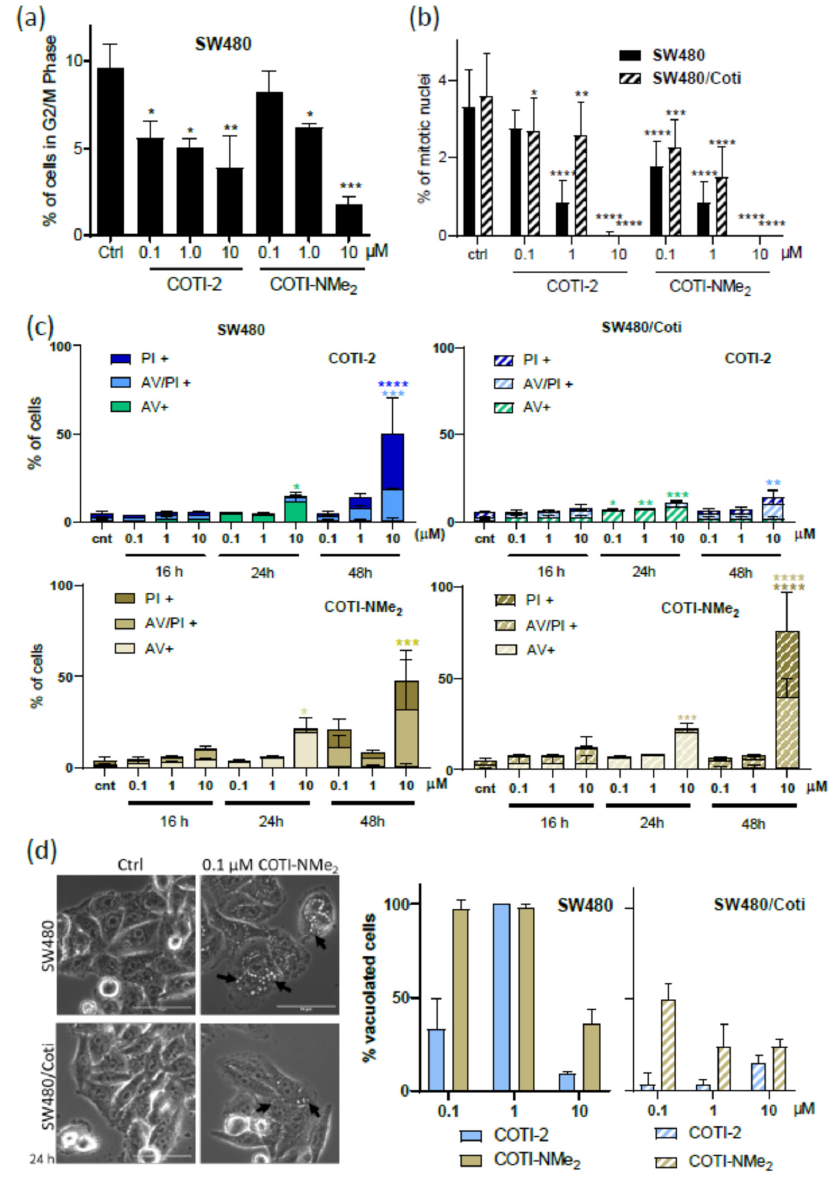
Figure 8. Cell cycle arrest and cell death induction by COTI-2 in SW480 and SW480/Coti cells after 24 h of treatment. ( a ) The percentage of cells in the G2/M phase was analyzed by staining ethanol-fixed cells with propidium iodide (PI) followed by flow cytometry after 24 h treatment. The mean ± SD was derived from three independent experiments. ( b ) Nucleic morphology was analyzed by the DAPI staining of methanol/acetone (1:1)-fixed cells after 24 h of treatment. Microscopic images were captured and mitotic cells were counted with ImageJ. The mean ± SD was derived from triplicates of three independent experiments. ( c ) Cell death induction was analyzed by annexin V (AV) and PI staining followed by flow cytometry. The mean ± SD was derived from three independent experiments after treatment at the indicated time points. ( d ) Microscopy images of paraptotic vesicle formation (indicated by black arrows) in SW480 and SW480/Coti cells after 24 h of treatment with COTI-2 and COTI-NMe 2 , and the percentage of vacuolated cells was counted with Image J. The mean ± SD was derived from three independent experiments. Significance was calculated in ( a ) with one-way ANOVA and the Holm-Sidak’s multiple comparisons test, ( b ) two-way ANOVA with Sidak’s multiple comparisons test and ( c ) two-way ANOVA with Dunnett’s multiple comparisons test ( p < 0.05 *, p < 0.01 **, p < 0.001 ***, p < 0.0001